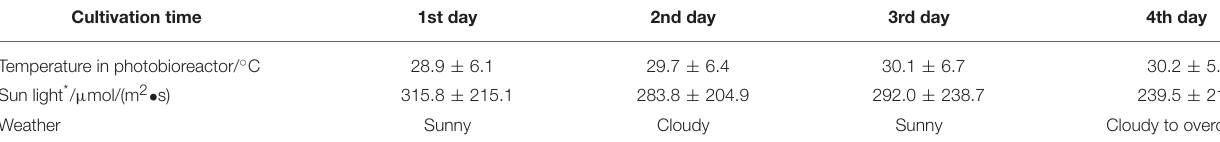
TABLE 3 | The fluctuation of irradiance and air temperature of each day under outdoor conditions with only air ventilation or HAc addition. Cultivation time